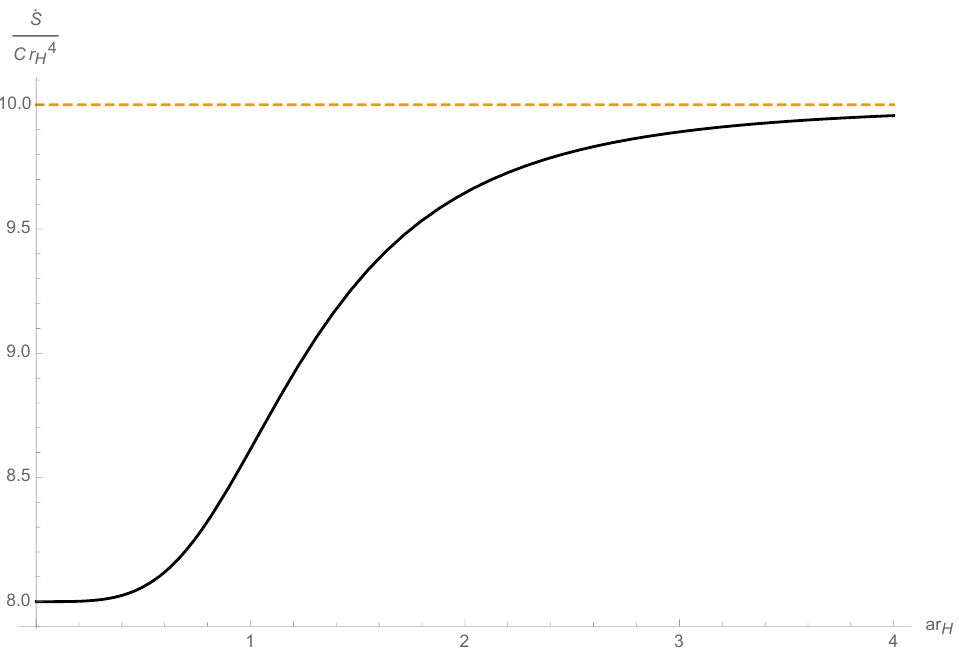
and extra r H dependence, ^ g 2 s